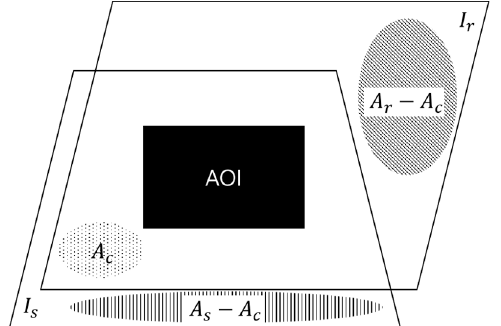
Table 3. Comparison between real flight and simulator in the detection of shaded area.